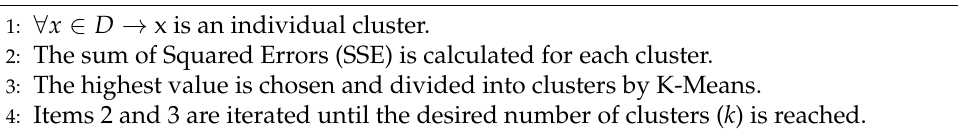
Algorithm 3 Hierarchical Clustering by Division: Bisecting